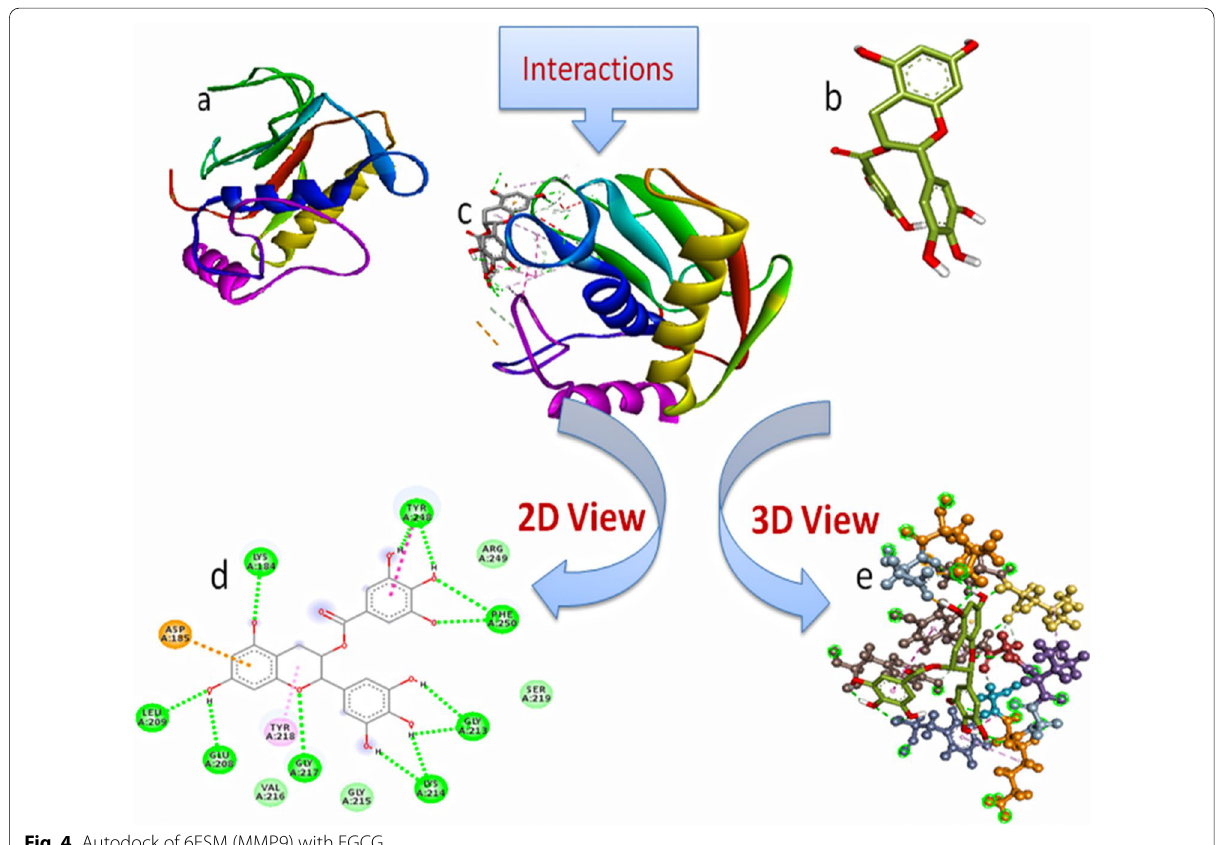
Fig. 4 Autodock of 6ESM (MMP9) with EGCG